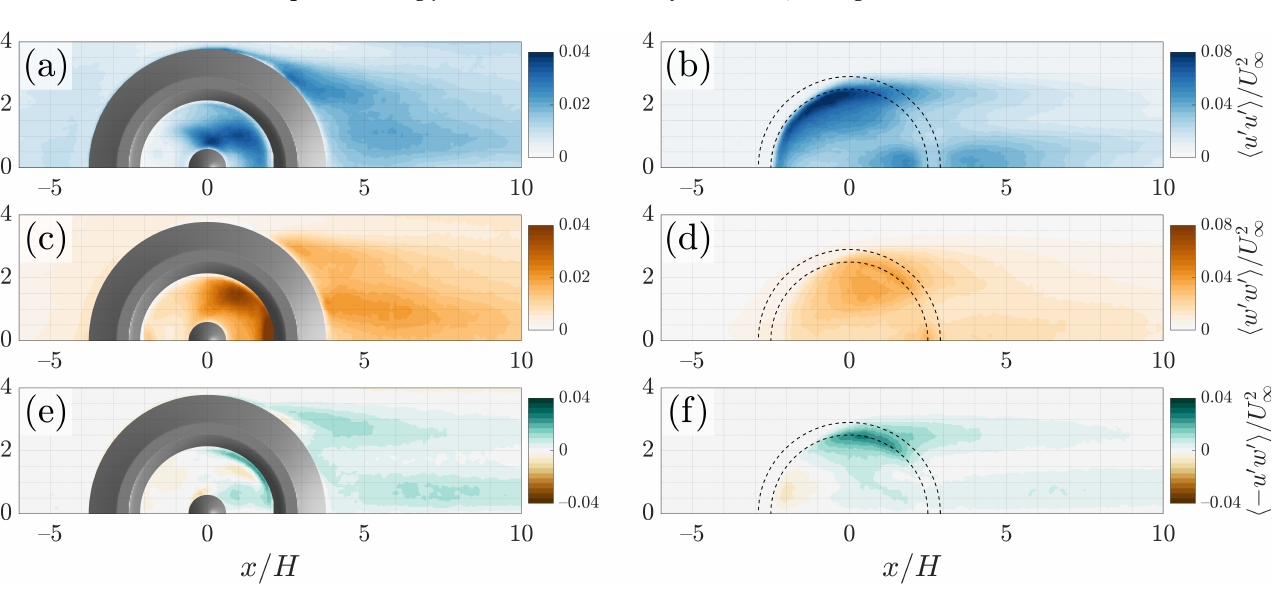
Figure 13. Contours of normalized ( a , b ) (cid:104) u (cid:48) u (cid:48) (cid:105) , ( c , d ) (cid:104) w (cid:48) w (cid:48) (cid:105) , and ( e , f ) (cid:104)− u (cid:48) w (cid:48) (cid:105) in the wall-parallel measurement planes at ( a , c , e ) y / H = 0.6 and ( b , d , f ) y / H = 1.1. The dashed circles demarcate the location of the crater rim. Re H = 8.9 × 10 3